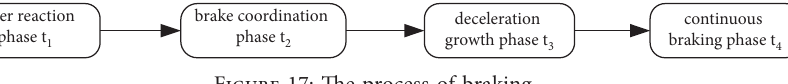
Figure 17: The process of braking.